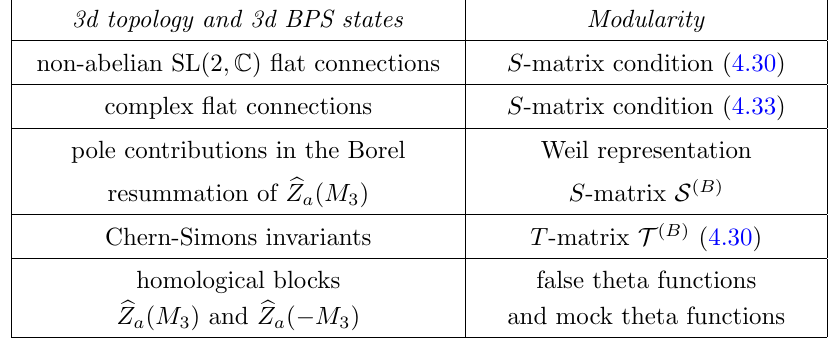
Table 2 . The correspondence between modularity and topology/BPS